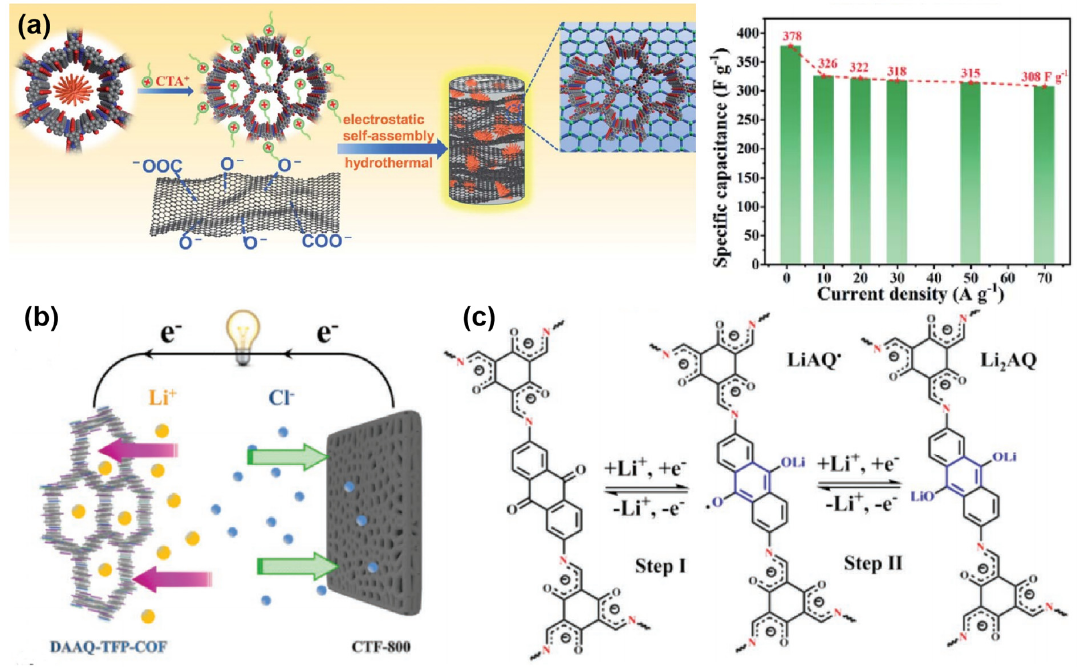
Figure 2. ( a ) Schematic of the synthesis procedure for the D − COF − GA composite and specific capacitances versus the current densities of D − COF/GA from 1 to 70 A g − 1 . Reprinted with permission from Ref. [39]. Copyright 2021, Royal Society of Chemistry. ( b ) Schematic diagram of the DT − COF//CTF − 800 ALIC device; ( c ) The principle of the device involves two steps single − electron redox processes. Reprinted with permission from Ref. [40]. Copyright 2022, WILEY-VCH.